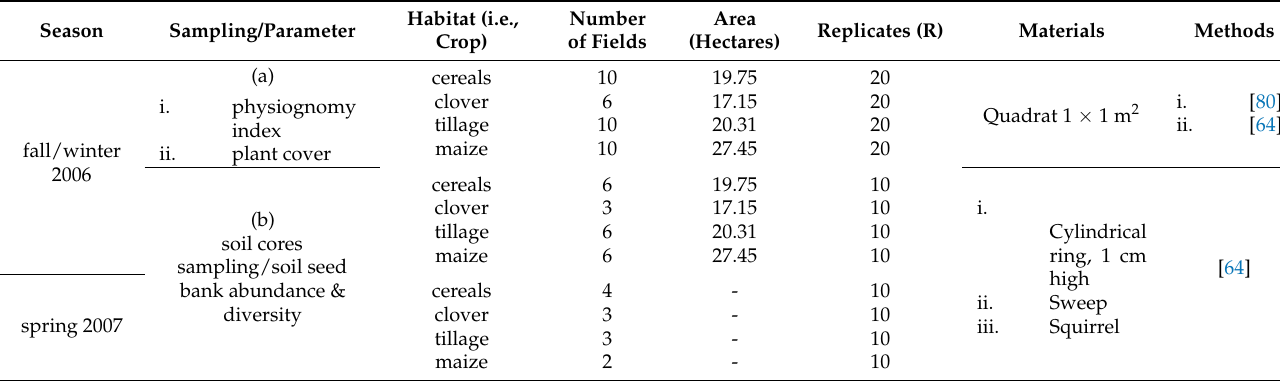
Table A4. Summary of the studied fields, sampling plots and methods [38].